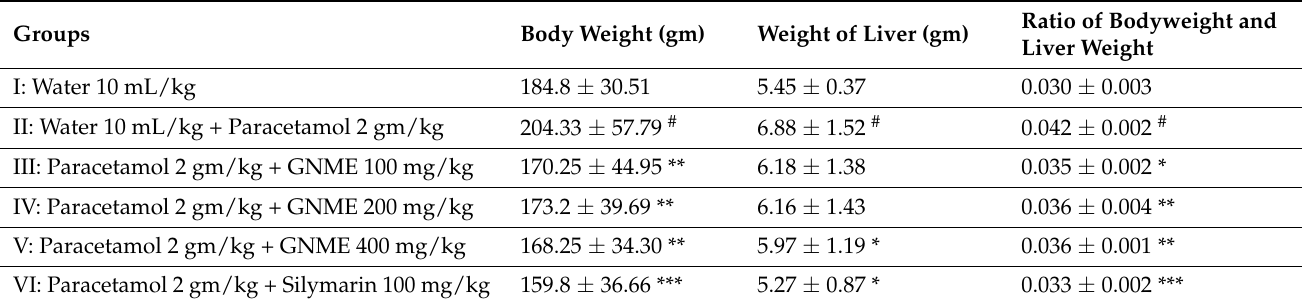
Table 2. Body and liver weight ratio of rats after the administration of